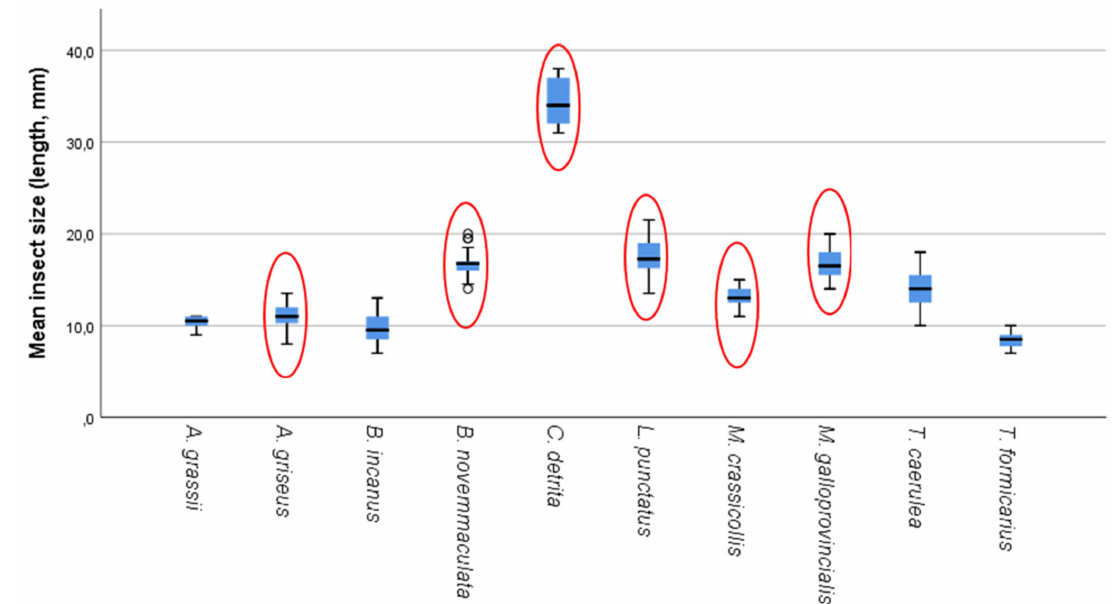
Figure 7. Body length (mm) of the trapped insect species. Red ovals represent species with a subsequent significant catch reduction in modified traps. Bars indicate standard